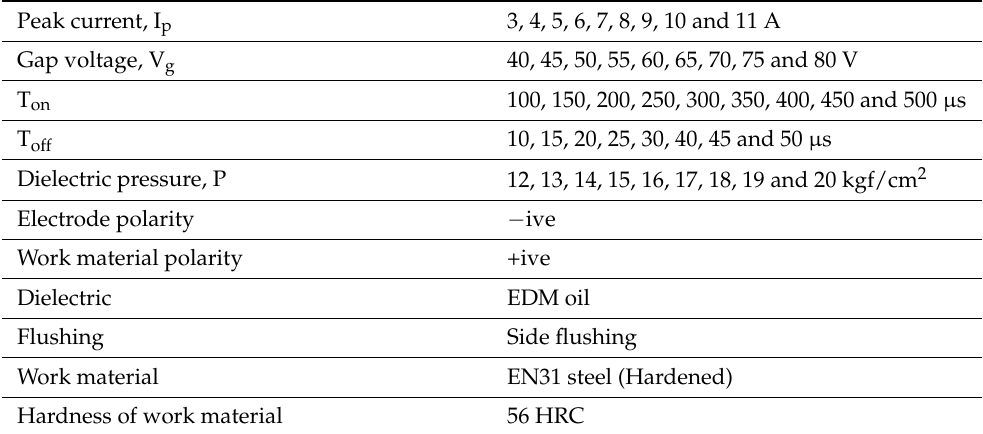
Table 4. Experimental